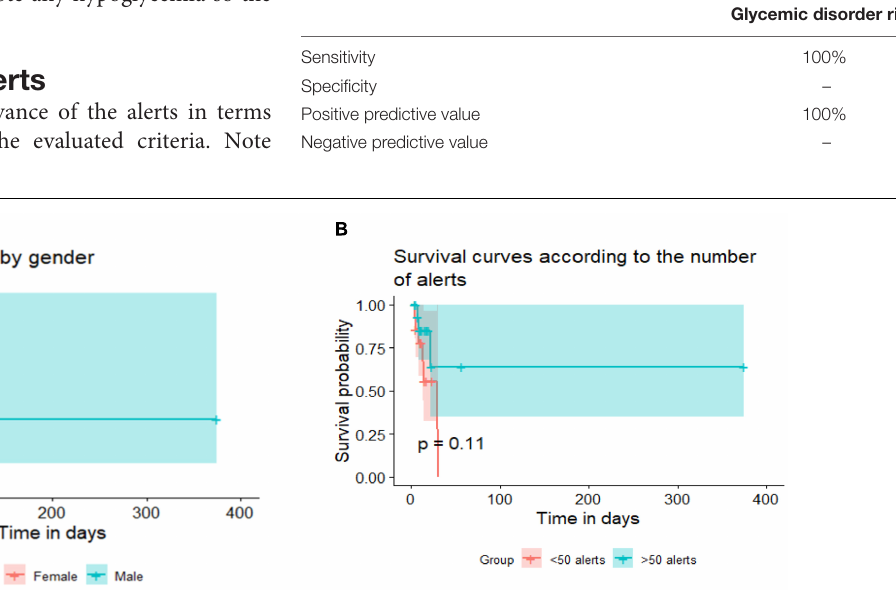
Frontiers in Physiology |